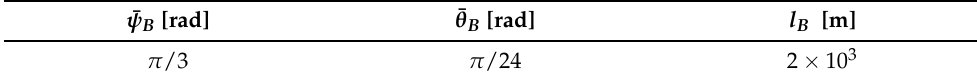
Figure 6. Seeker beam geometry of scenario B. Table 6. Numerical values for beam formulation on scenario